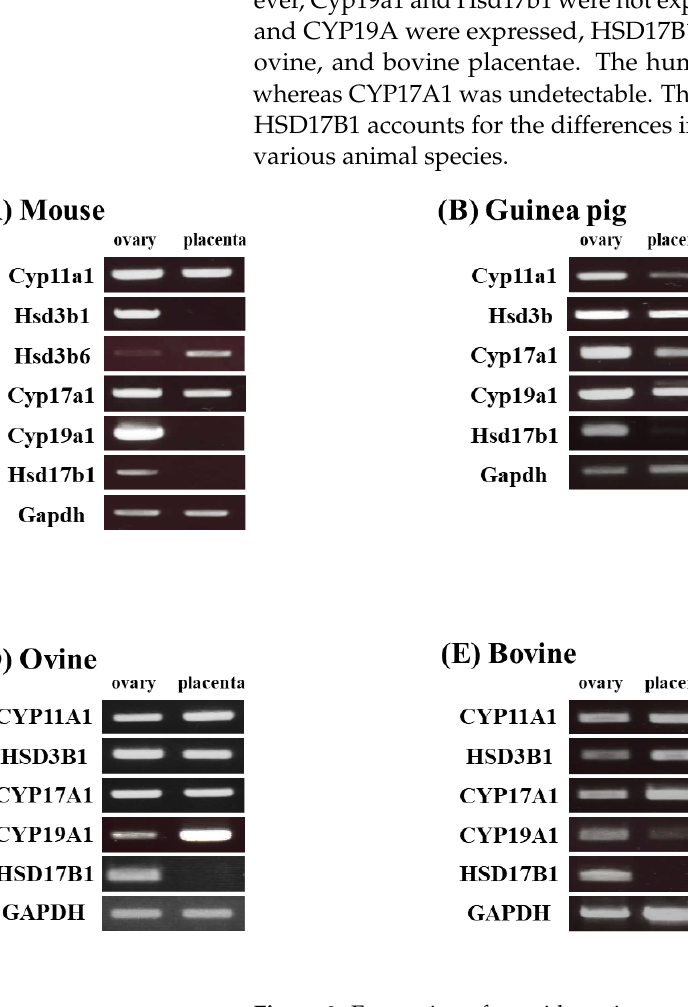
Figure 2. Expression of steroidogenic genes in ovary and placenta of various mammalian species. RT-PCR analyses of each gene in the ovary and placenta of a mouse ( A ), guinea pig ( B ), porcine ( C ), ovine ( D ), bovine ( E ), and human ( F ).